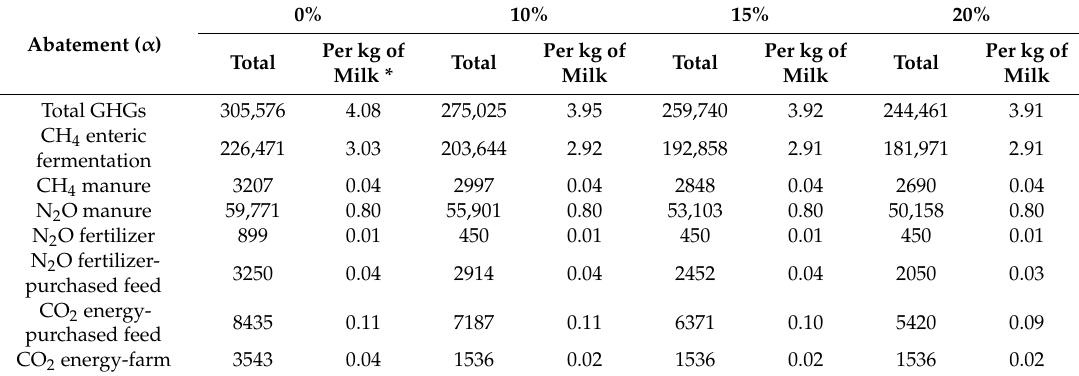
Table 6. Annual greenhouse gas (GHG) emissions of the extensive farm (in kg of CO 2 -eq).